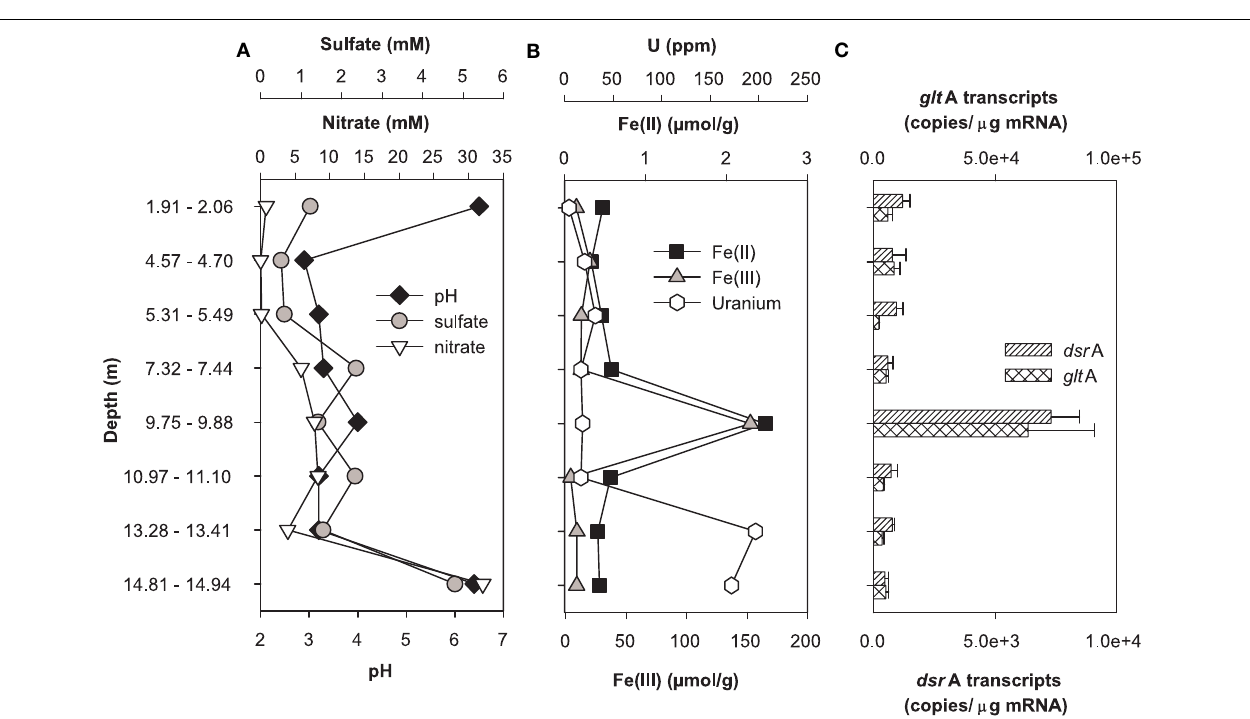
on a pooled sample from triplicate borehole sediment samples. Nitrate, sulfate, pH, iron, and uranium data were reported previously as supplemental material in Green et al.